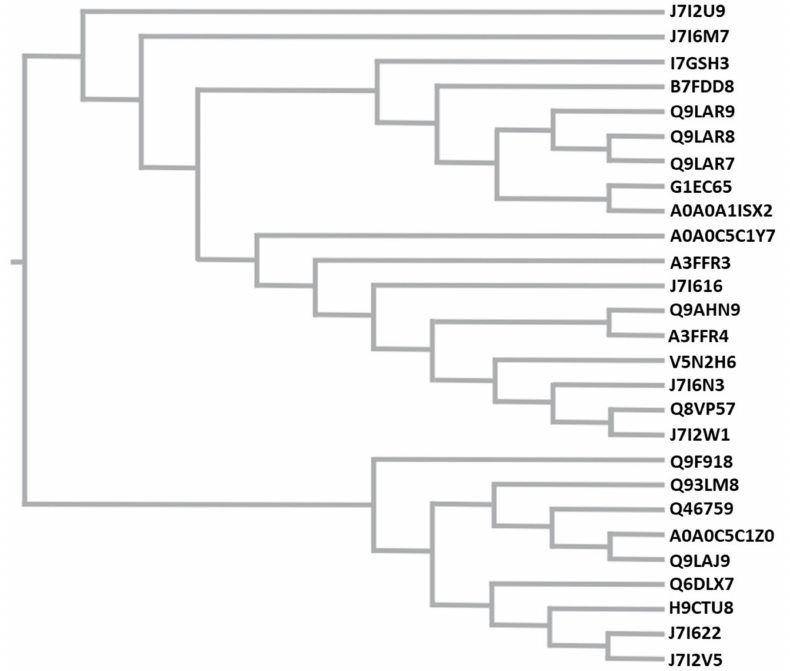
Figure 4. Phylogenetic tree displaying all β -lactamase isoforms detected in the analysed samples using the FastTree function of GenomeNet (https: // www.bic.kyoto-u.ac.jp / ).